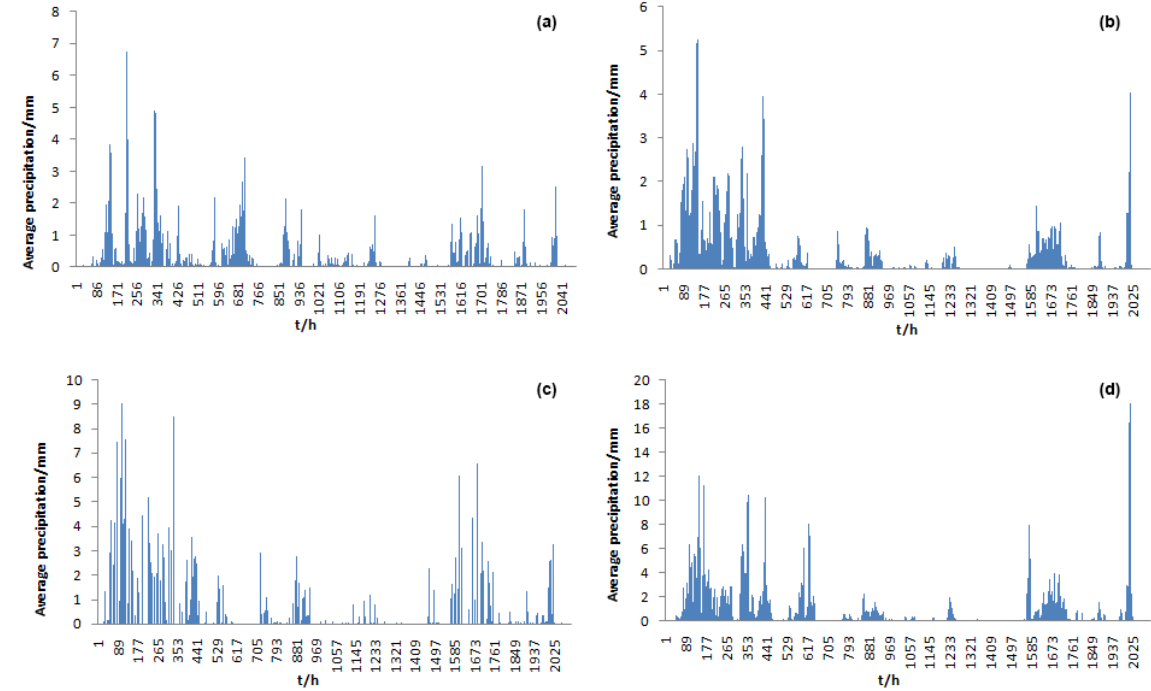
Figure 2. Precipitation pattern comparison of two precipitation products (2011). (a) is the average precipitation of rain gauges, (b) is the average precipitation of WRF with 24h lead time, (c) is the average precipitation of WRF with 48h lead time, and (d) is the average precipitation of WRF with 72h lead